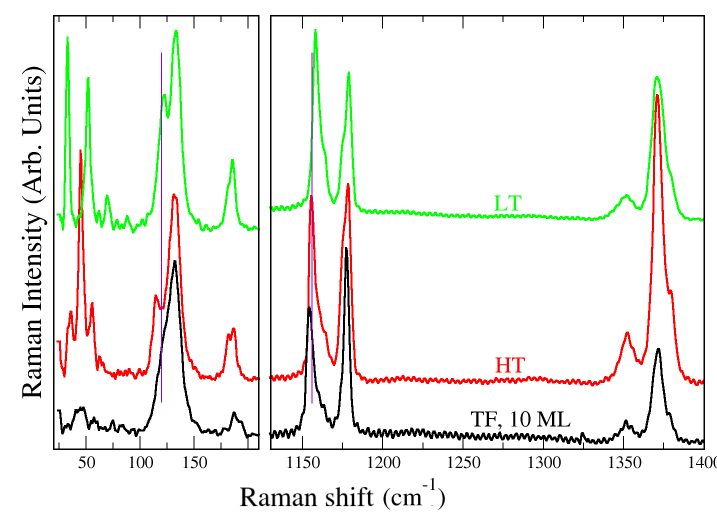
Figure 6. Low- and high-frequency unpolarized Raman spectra of the three pentacene polymorphs. The spectra are offset for